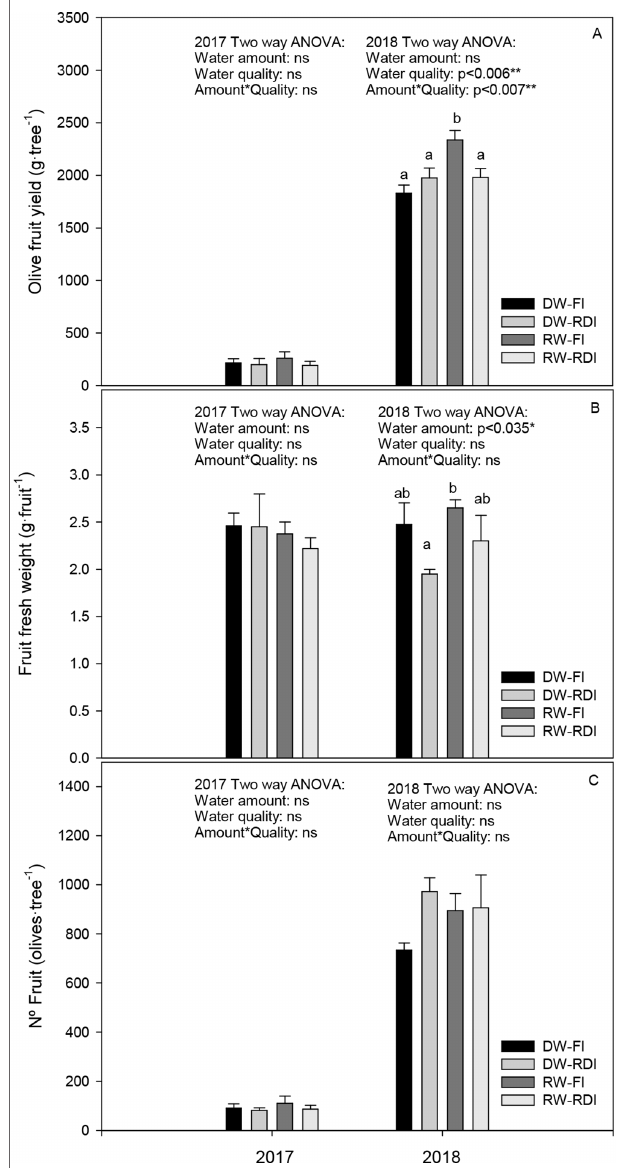
FIGURE 2 | (A) Olive fruit yield (g tree−1), (B) fruit fresh weight (g fruit−1) and (C) number of fruit (olives tree−1) for each treatment: DW-FI (DESERT water- full irrigation), DW-RDI (DESERT water-regulated deficit irrigation), RW-FI (reclaimed water-full irrigation), and RW-RDI (reclaimed water-regulated deficit irrigation) for 2017 and